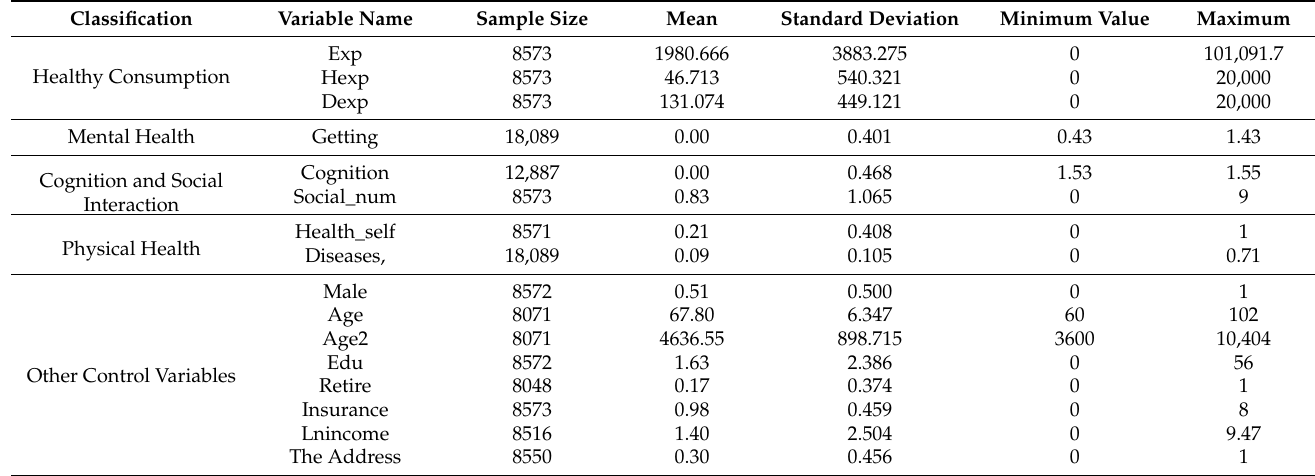
Table 4. Descriptive statistical results based on national baseline survey data in 2015.